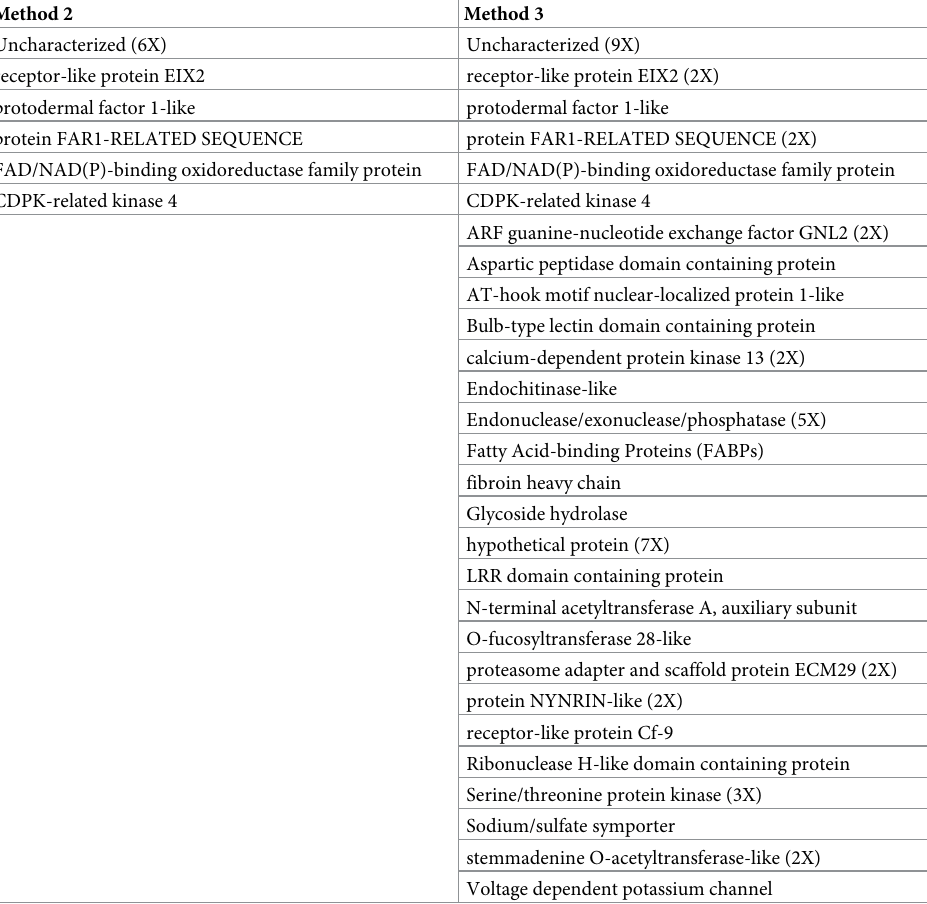
Table 2. Genes with significant associations for chemical